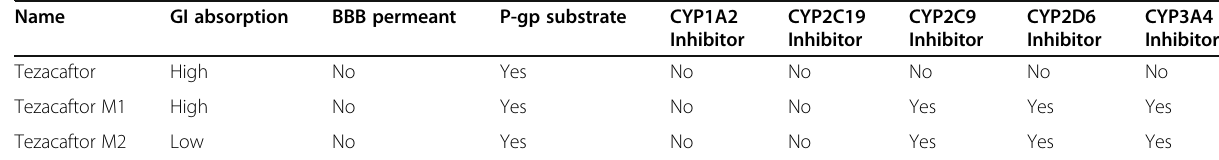
Table 18 Predicted molecular pharmacokinetic properties of Tezacaftor and their metabolites using Swiss ADME database Name